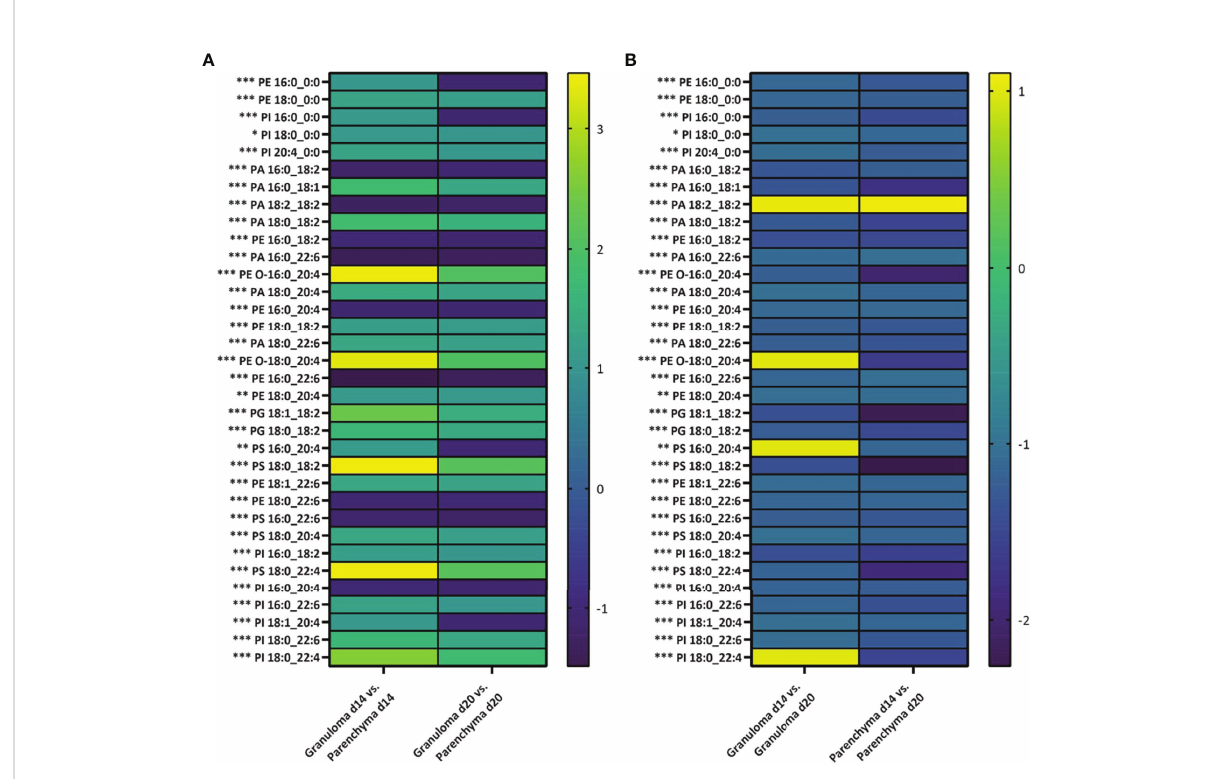
FIGURE 6 Differing abundance of lipids in granulomas and parenchyma over time of infection. Log2 fold changes in average relative intensities of lipids deduced from granulomas and parenchyma regions of interest (ROIs) from d14 and d20 p.i. (n=5 mice and 100 granulomatous and parenchymal ROIs per time point). (A) For each lipid, the fold change is presented for lipid intensity in granuloma ROIs compared to parenchymal ROIs for d14 and d20 parasitized mouse livers. (B) For each lipid, the fold change is presented for lipid intensity from granuloma or parenchymal d14 ROIs compared to granuloma or parenchymal d20 ROIs. Signi fi cance is de fi ned as *p<0.05, **p<0.01 or ***p<0.001. P-values are adjusted for multiple comparisons. PA, phosphatidic acids; PE, phosphatidylethanolamines; PC, phosphocholine; PI, phosphatidylinositols; PS, phosphatidylserines; and PG,